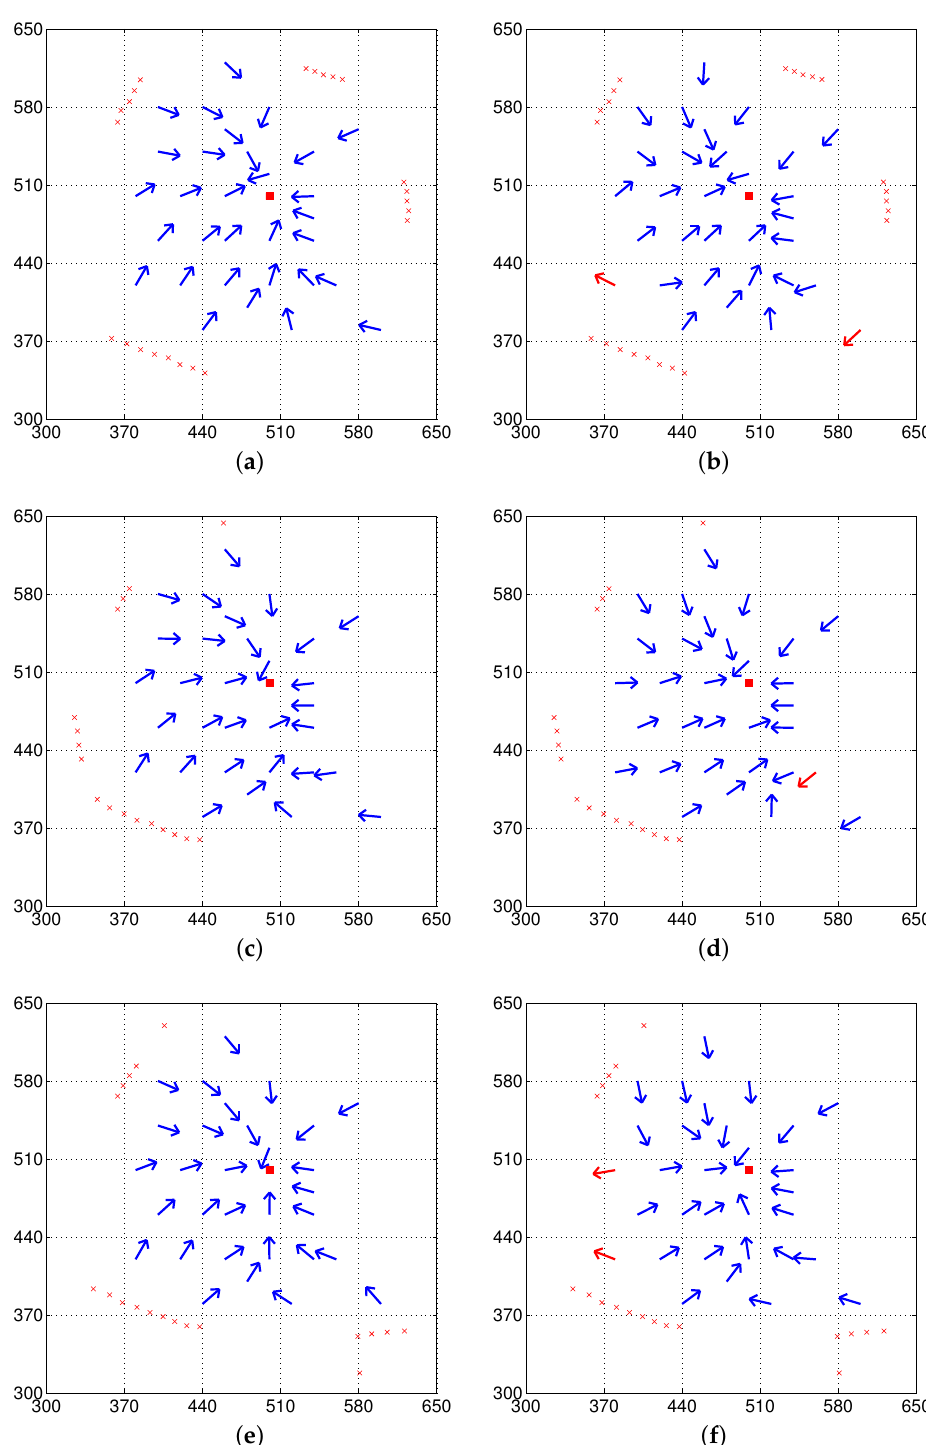
Figure 9. Vector map results with the H-DELV method (left column: with the reference compass, right column: without the reference compass); ( a , b ) env1; ( c , d ) env2; ( e , f ) env3 (red x marks indicate landmarks for H-DELV, which uses a uniform distribution of depth samples including far background areas not shown, although they are